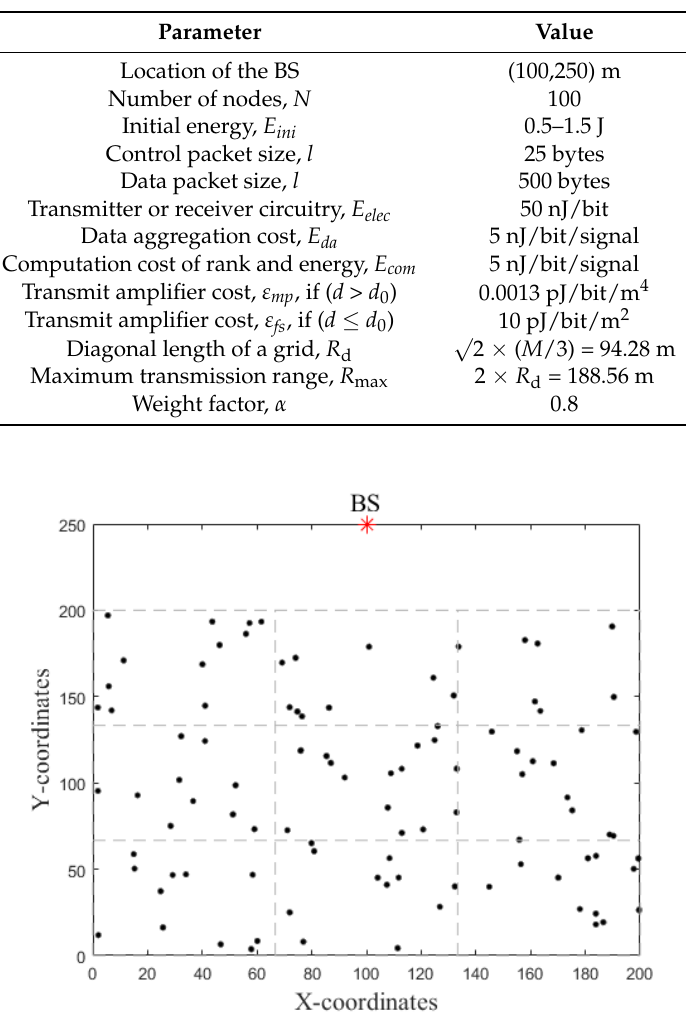
Table 3. Simulation parameters setting.